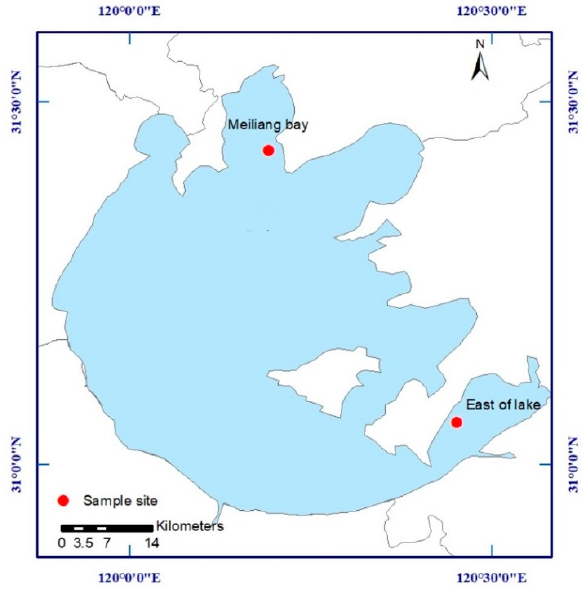
Figure 1. Location of sampling sites in Taihu Lake.